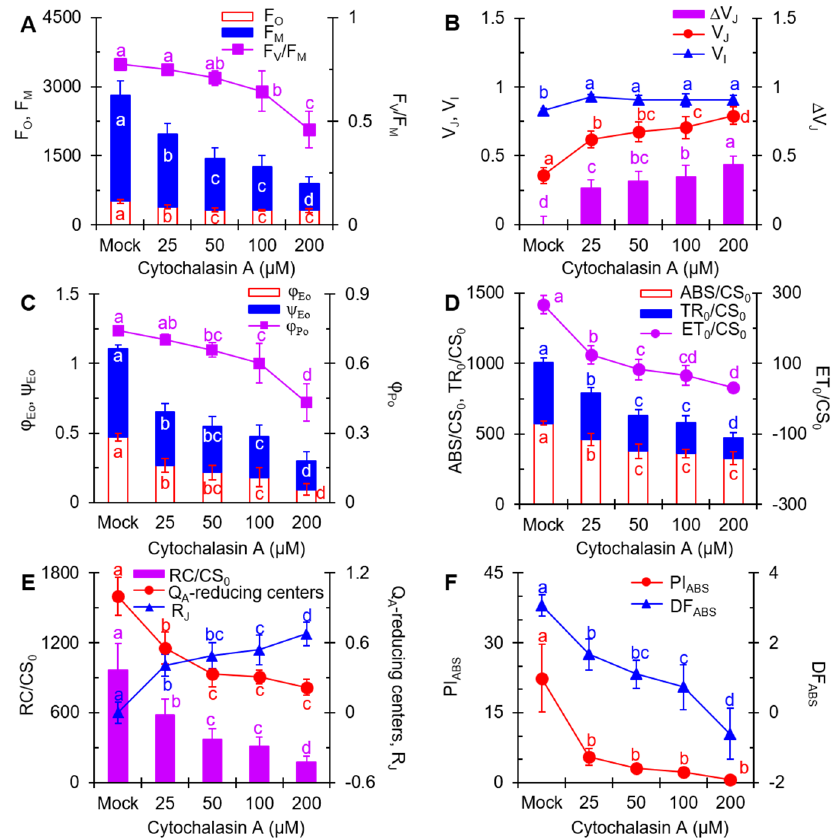
Figure 4. Changes of selected JIP-test fluorescence parameters of A. adenophora leaf discs treated with different concentrations of cytochalasin A. ( A ) F O , F M and F V /F M . ( B ) V J , V I and ∆ V J . ( C ) φ Eo , ψ Eo and φ Po . ( D ) ABS/CS 0 , TR 0 /CS 0 and ET 0 /CS 0 . ( E ) RC/CS 0 , Q A -reducing centers, R J . ( F ) PI ABS and D.F. Each curve is the average of three independent experiments with around 15 repetitions. The different lowercase letters (a,b,c,d) indicate to be statistical significance at 0.05 level.